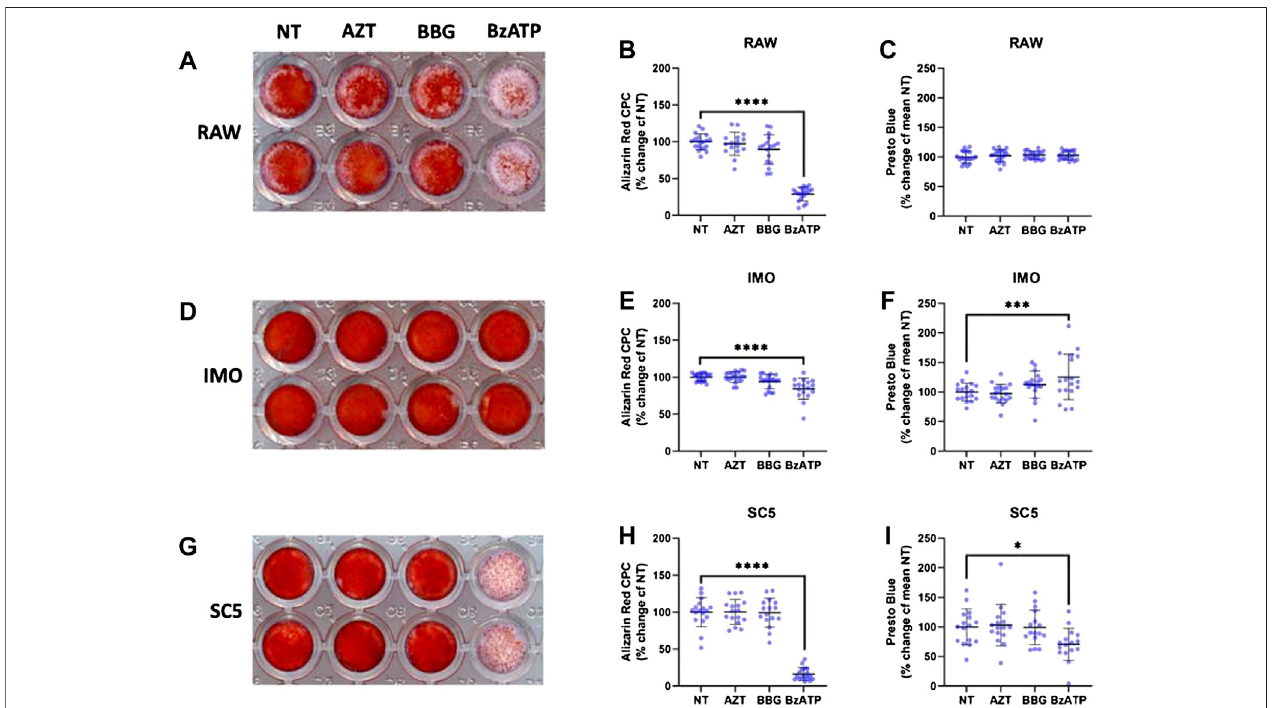
FIGURE 5 | Role of P2X7 in mineralisation of RAW 264.7, IMO and SC5 cells. Cultures of RAW 264.7, IMO and SC5 cells were treated with high phosphate (HP) media, in combination with the P2X7 inhibitors AZT and BBG and the agonist BzATP for 48 h. Cell viability was measured with the Presto Blue assay and mineralisation visualised with Alizarin Red staining that was quanti fi ed with the CPC method. (A,B) Mineralisation of RAW 264.7 cells in HP media was decreased by the P2X7 agonist BzATP(****= p < 0.0001,univariateanalysiswithDunnett ’ spost-testsinSPSS). (C) ViabilityofRAW264.7cellsremainedunalteredacrosstreatmentgroups. (D,E) Mineralisation ofIMO cells in HPmedia isdecreased bythe P2X7 agonist BzATP (**** = p < 0.0001, univariate analysis with Dunnett ’ spost-tests in SPSS). (F) Viability of IMO cells was increased by the P2X7 agonist BzATP (*** = p < 0.0001, univariate analysis with Dunnett ’ s post-tests in SPSS). (G,H). Mineralisation of SC5 cells in HP media was decreased by the P2X7 agonist BzATP (**** = p < 0.0001, univariate analysis with Dunnett ’ s post-tests in SPSS). (I). Viability of SC5 cells was decreased by the P2X7 agonist BzATP (*** = p < 0.0001, univariate analysis with Dunnett ’ s post-tests in SPSS).